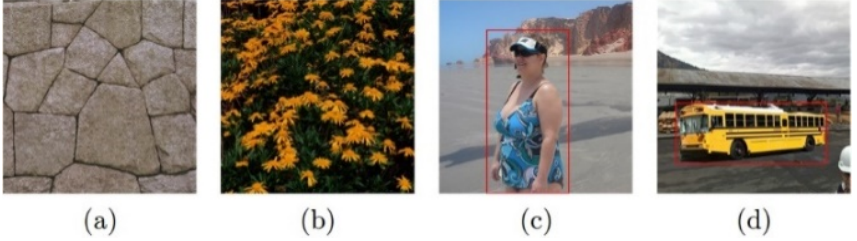
Figure 4. Examples of the images in Tampering ImageNet. ( a , b ) Untampered images; ( c , d ) tampered images.